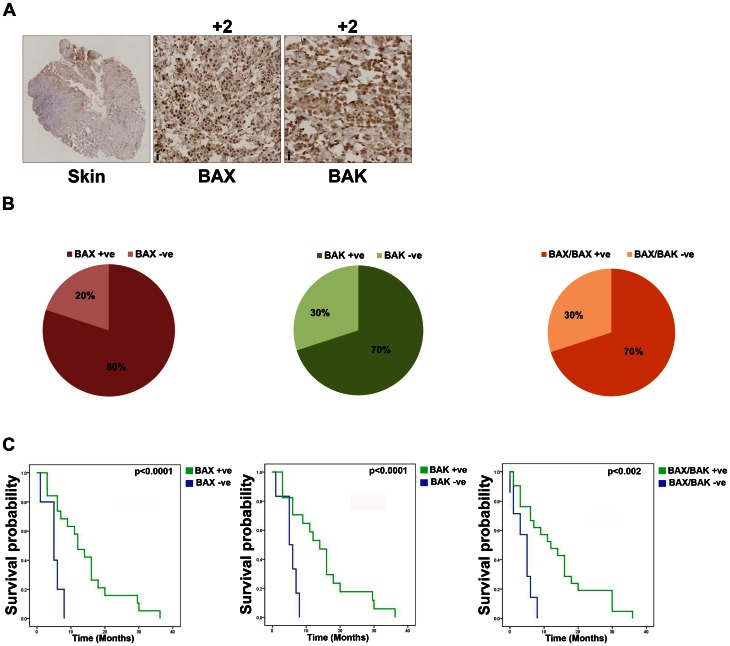
Immunohistochemical analysis of BAX and BAK expression in malignant mesothelioma patients.A) Representative image of normal tissue control and positive tissues stained for BAX and BAK by immunohistochemisty. B) Pie-charts representing the frequency of BAX, BAK and BAX-BAK negativity in previously treated 30 mesothelioma patients. C) Kaplan Meier curves correlating BAX, BAK, and double BAX/BAK expression respectively with survival in the total of 30 previously-treated patients.